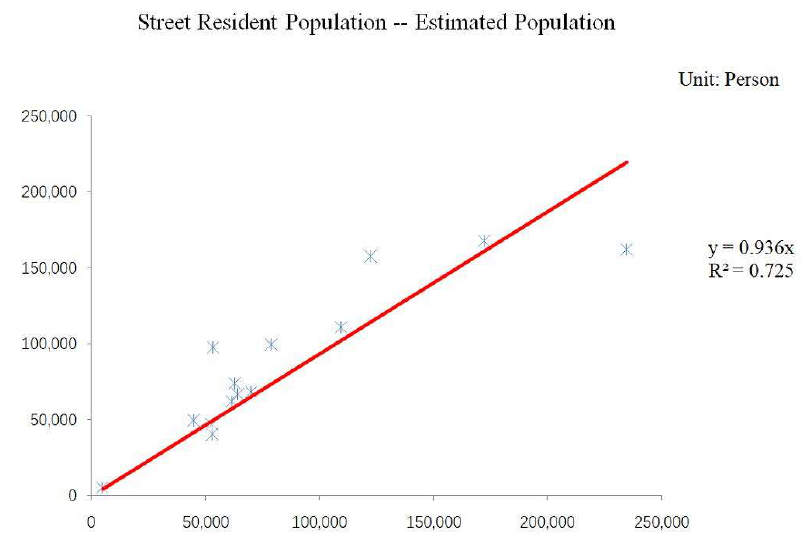
Figure 7. The Fit of the Street Population and Estimated Population.